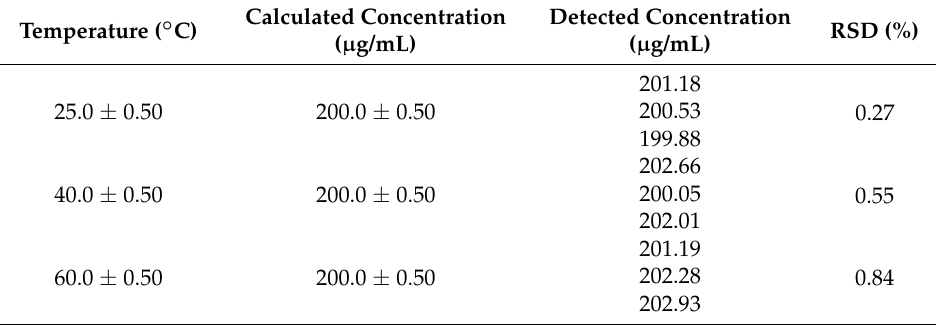
Table 2. Stability of TP 5 at different temperatures (n = 3).